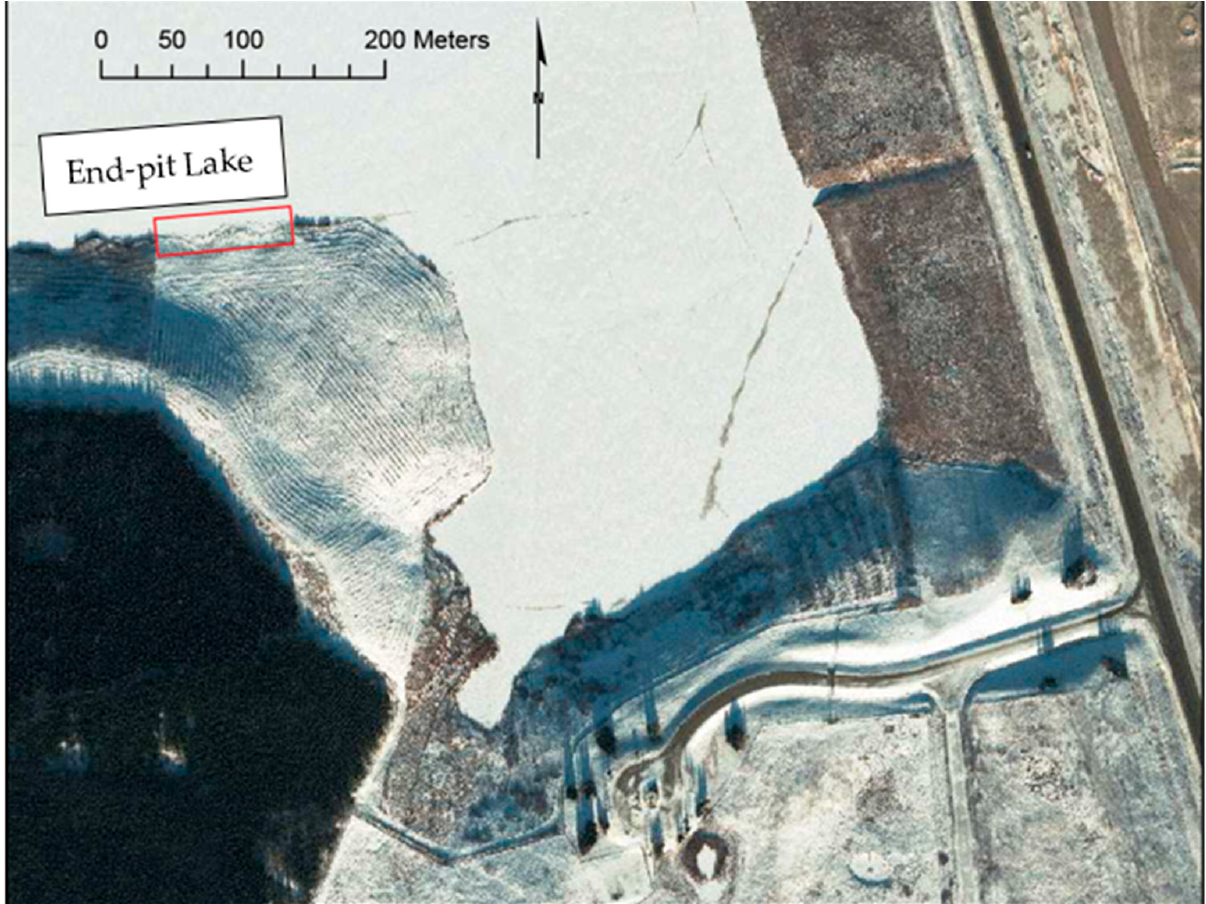
Figure A2. Aerial view in winter of the end-pit lake showing the location (marked in red) of the trial adjacent to the lake edge.